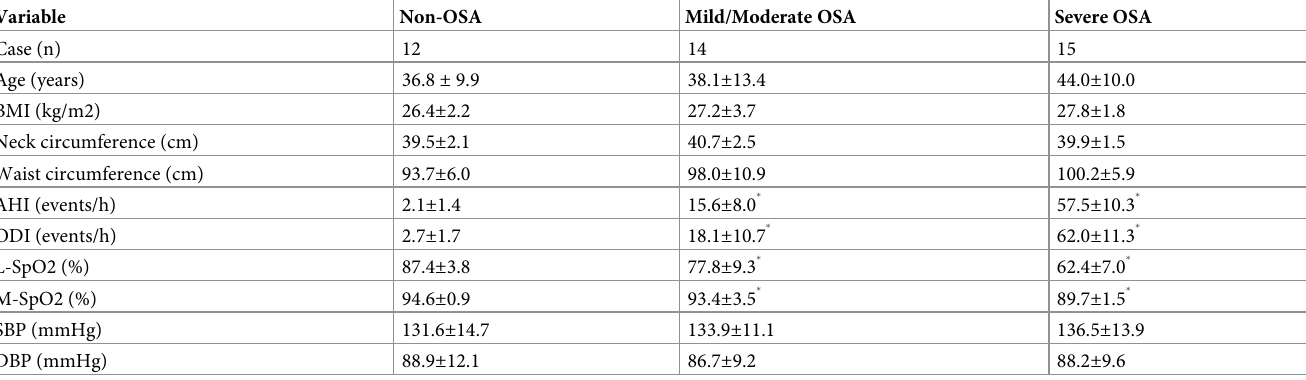
Table 2. General characteristics of each